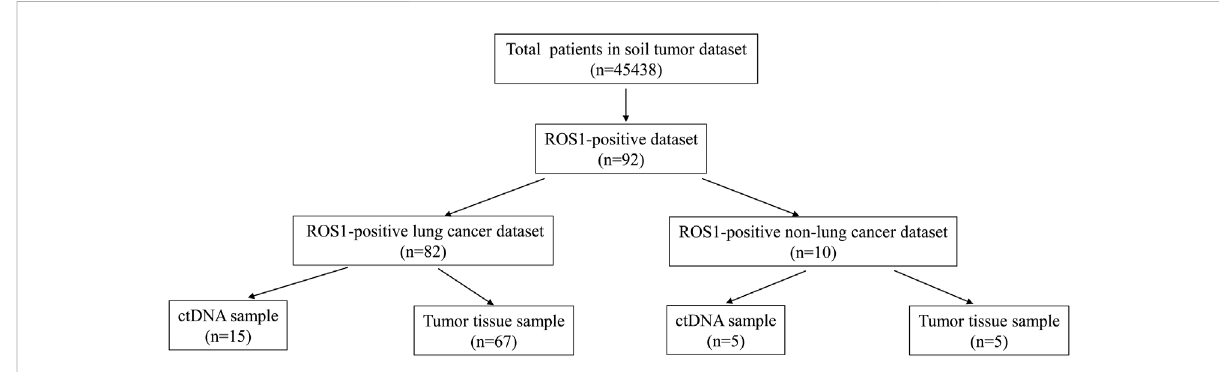
FIGURE 1 Study population. Schematic representing the population of patients in this study.